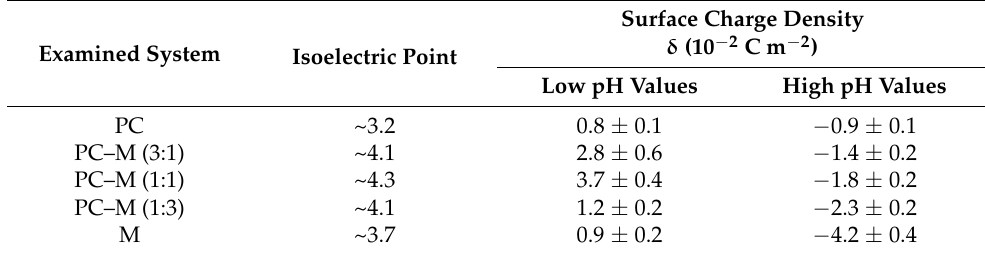
Table 3. The surface charge densities and isoelectric points for the PC–M